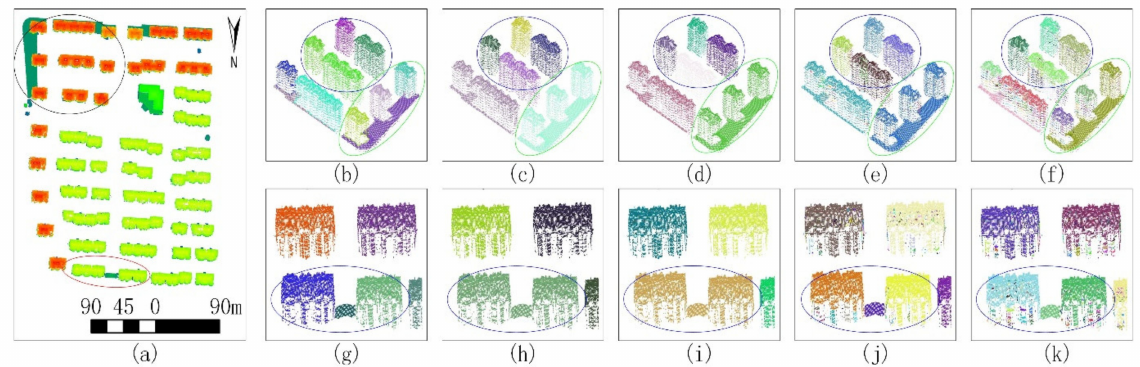
Figure 18. Typical area building instance segmentation result of dataset 3: ( a ) the building point clouds; ( b ) result of the UBIS method; ( c ) result of the MV method; ( d ) result of the ES2D method; ( e ) result of the ES3D method; ( f ) result of LCCP the method; ( g ) result of the UBIS method; ( h ) result of the MV method; ( i ) result of the ES2D method; ( j ) result of the ES3D method; ( k ) result of the LCCP